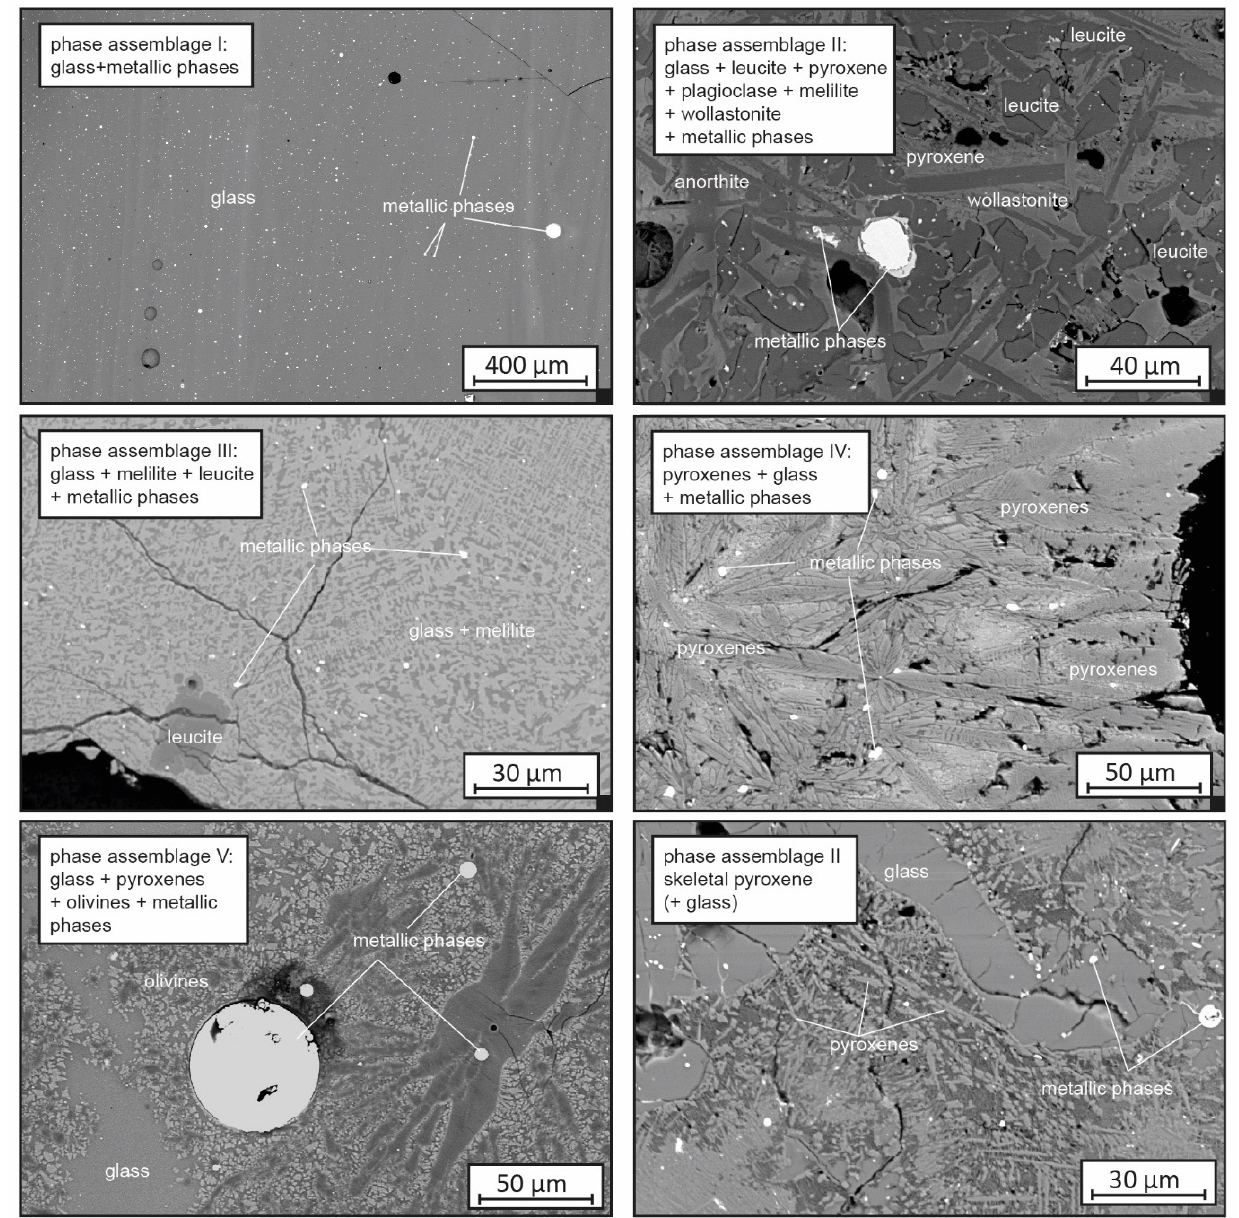
Figure 5. BSE images presenting different phase assemblages discovered in the analysed slags.